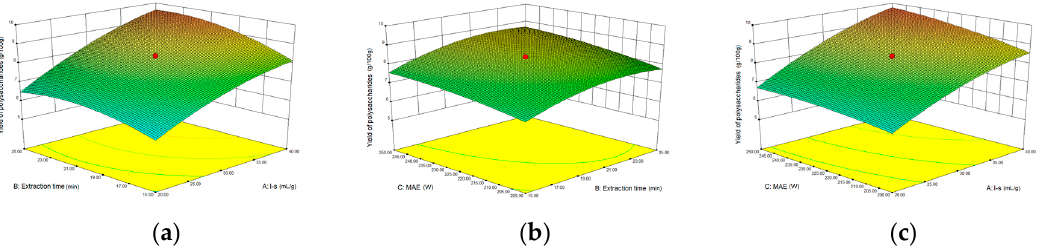
Figure 5. The response surface for the effect of independent variables on microwave ‐ assisted extraction efficiency of polysaccharides. ( a ) Solid–liquid ratio and extraction time, ( b ) extraction time and microwave power, ( c ) solid–liquid ratio and microwave power.